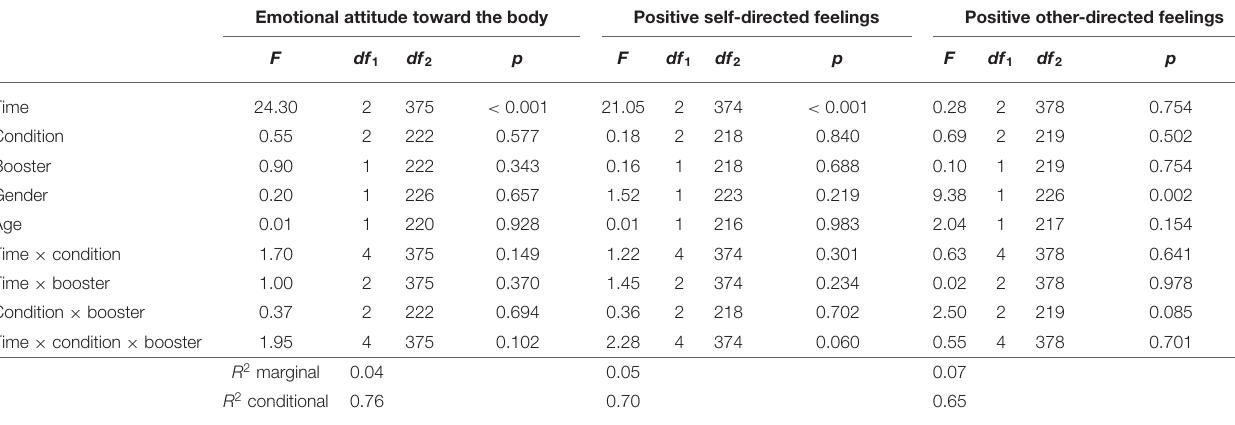
TABLE 3 | Results of the LMM analyses for secondary outcomes, omnibus tests for fixed effects. Emotional attitude toward the body Positive self-directed feelings Positive other-directed feelings